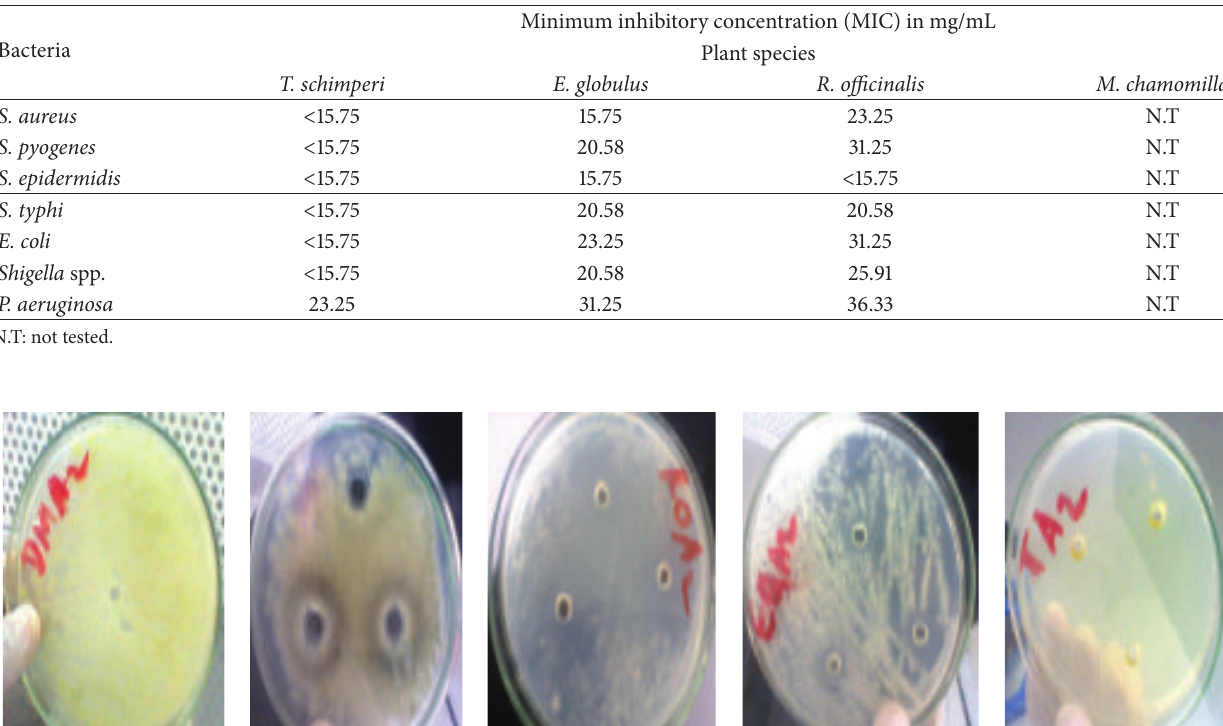
Table 4: Minimum inhibitory concentrations (MIC) of E. globulus , T. schimperi , and Rosmarinus officinalis essential oils against the tested bacteria.